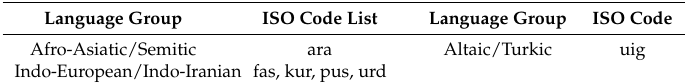
Table 3. Arabic script dataset.